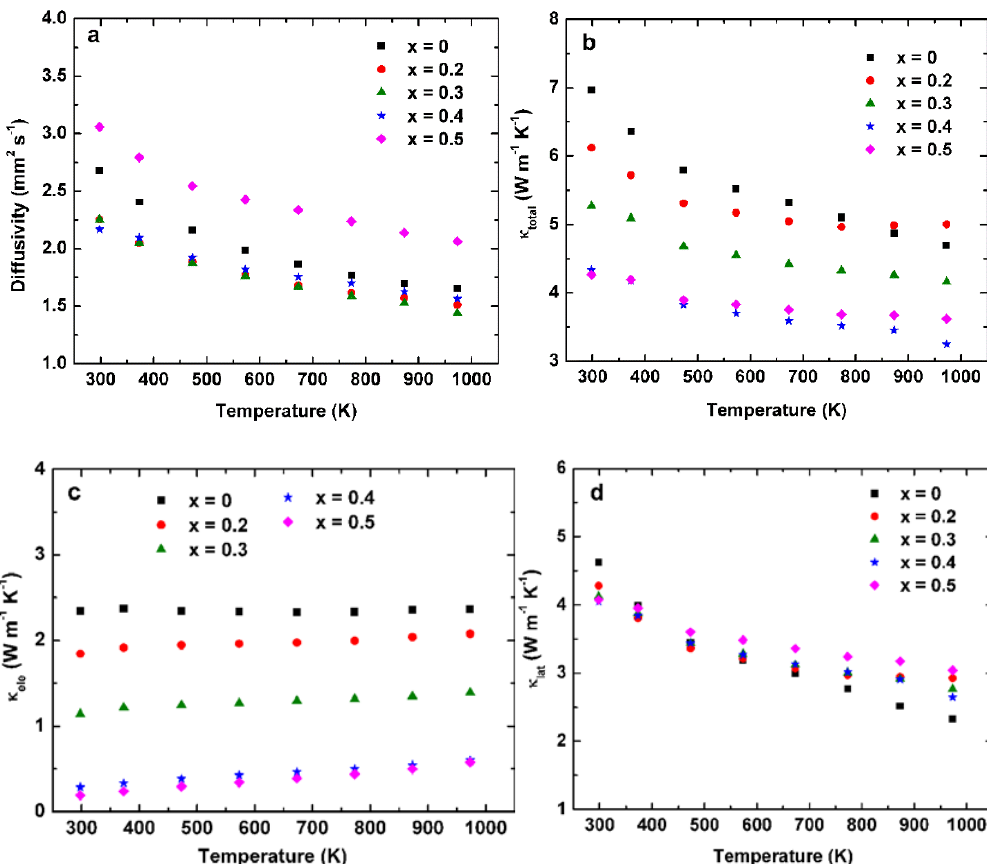
Figure 4. ( a ) Temperature-dependent thermal diffusivity; ( b ) total thermal conductivity; ( c ) electronic thermal conductivity; and ( d ) lattice thermal conductivity for NbCo 1+ x Sb.